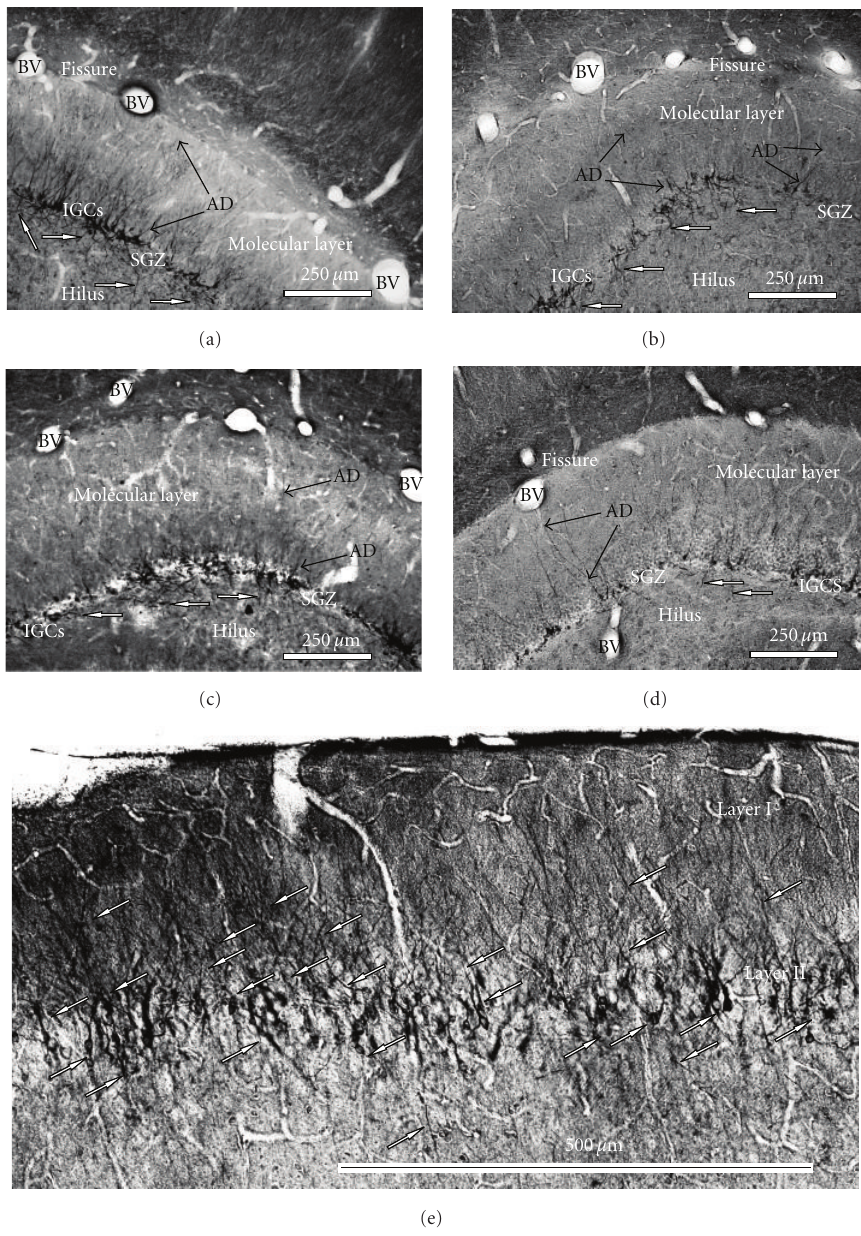
Figure 1: Comparative analysis of DG images of DCX-immunoperoxidase-labelled cells in S. undulatus in di ff erent functional states: (a) normothermic summer animal; (b) normothermic winter animal; (c) 2.5 h provoked arousal; (d) hibernation. Intensive DCX labelling of immature granule cell dendritic tree was revealed in normothermic summer animals (a) in contrast to winter animals (b–d). Solid arrows show DCX-labelled dendritic trees and their retraction in hibernating state. Open arrows show there is significant retraction of mossy fibres in hibernating S. undulatus (d) in comparison to summer animals (a): (e) DCX labelling of neurons in Layer II of entorhinal cortex in summer animal (open arrows). AD: apical dendrite of granule cell; BV: blood vessel; IGCs: immature granule cells; SGZ: subgranular zone of